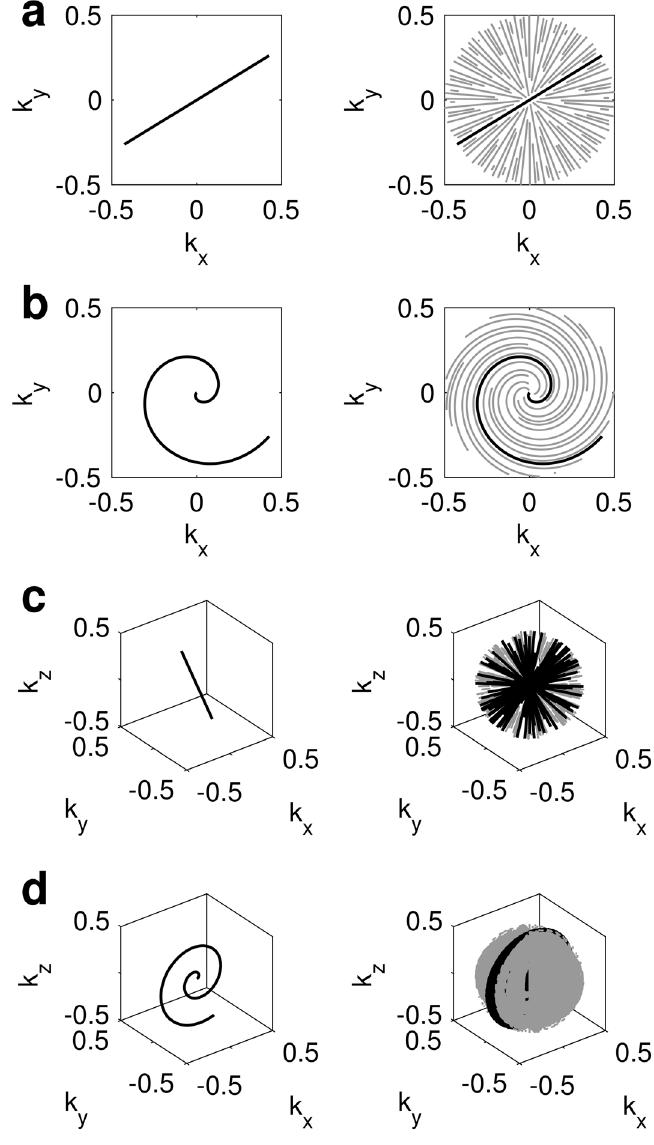
Figure 2. k -space weighted view-sharing with different acquisition trajectories. k -space weighted view-sharing consists of sharing spatial acquisition data within neighboring temporal frames to increase the number of samples per frame. This technique can be applied to all non-Cartesian trajectories, i.e. 2D radial ( a ), 2D spiral ( b ), 3D radial ( c ) and 3D spiral ( d )